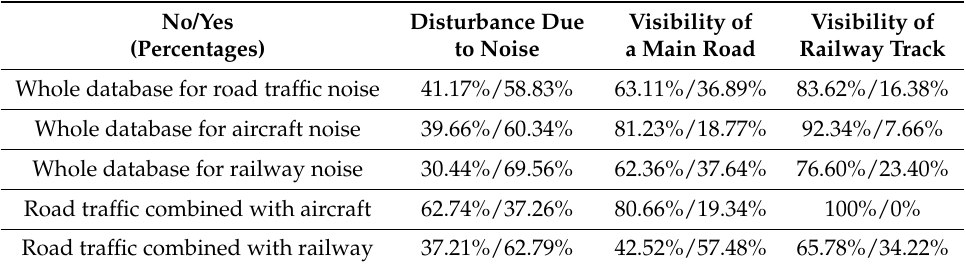
Table A1. Values of Yes-No variables in terms of